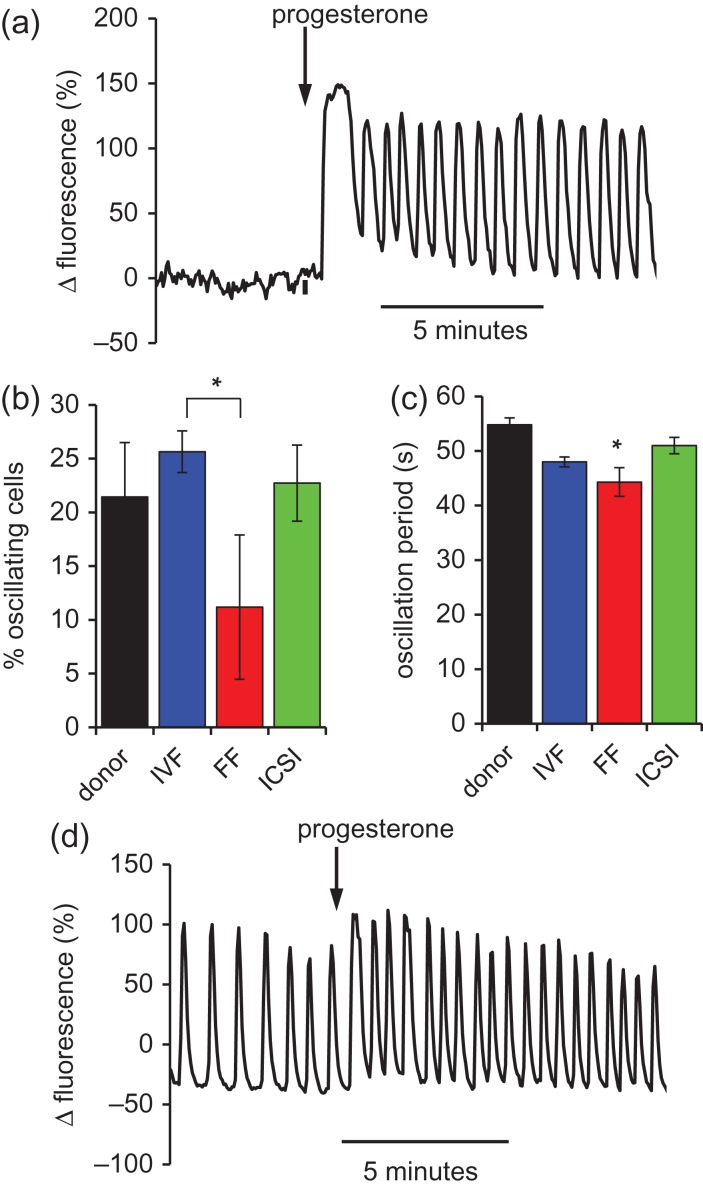
Calcium oscillations in progesterone-stimulated cells. (a) Representative trace of a P4-induced [Ca2+]i oscillation in single spermatozoon of an IVF (+ve) patient. 3.6 μM P4 was added at the arrow. (b) Proportion of cells that generated [Ca2+]i oscillations when stimulated with 3.6 μM P4. Bars show mean ± SEM for donors (black, n = 21 experiments), IVF(+ve) (blue, n = 62 experiments), and IVF-FF (red, n = 8 experiments and ICSI (green, n = 21 experiments). P < 0.05 (*). (c) Mean [Ca2+]i oscillation period (± SEM); donors (black, n = 143 cells), IVF(+ve) (blue, n = 582 cells), IVF-FF (red, n = 43 cells; P < 0.05 with respect to donors (*)) and ICSI (green, n = 162 cells). (d) Example of cell (successful IVF patient) generating large spontaneous [Ca2+]i oscillations, which persisted during P4 exposure.